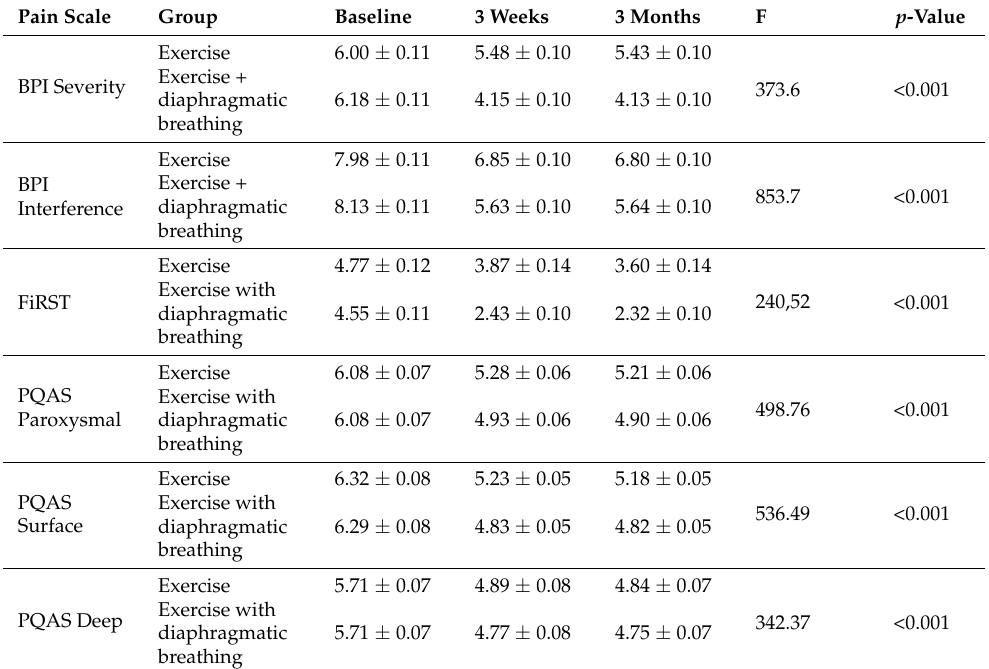
Table 3. Mean scores in the pain scales for every time-point for each group, and results of the mixed ANOVA for the time factor (F-within and p -value).